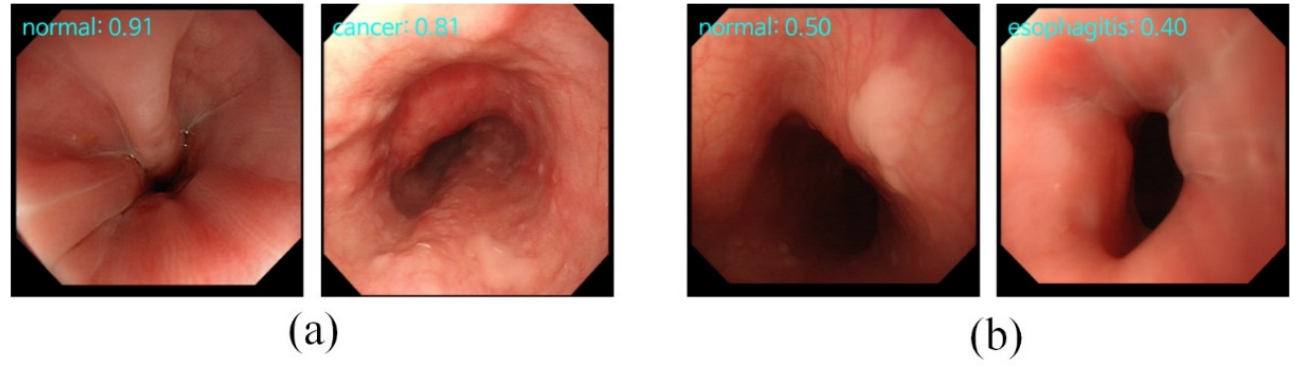
Figure 3. The results of classification and retrieval. “Type: 0.xx” on the top-left means the “predicted category: confidence level”. ( a ) The input images with high confidence levels indicate the high possibility of a correct prediction made by the classification task. ( b ) The input images with low confidence levels indicate the high possibility of an incorrect prediction made by the classification task.